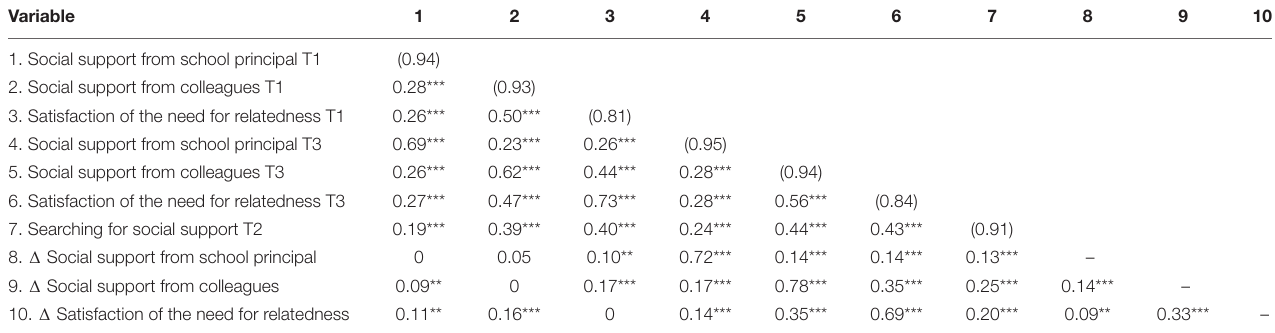
TABLE 1 | Zero-order correlations between variables at T1 and T3 and between model variables and cronbach’s alpha ( N = 1071). Variable